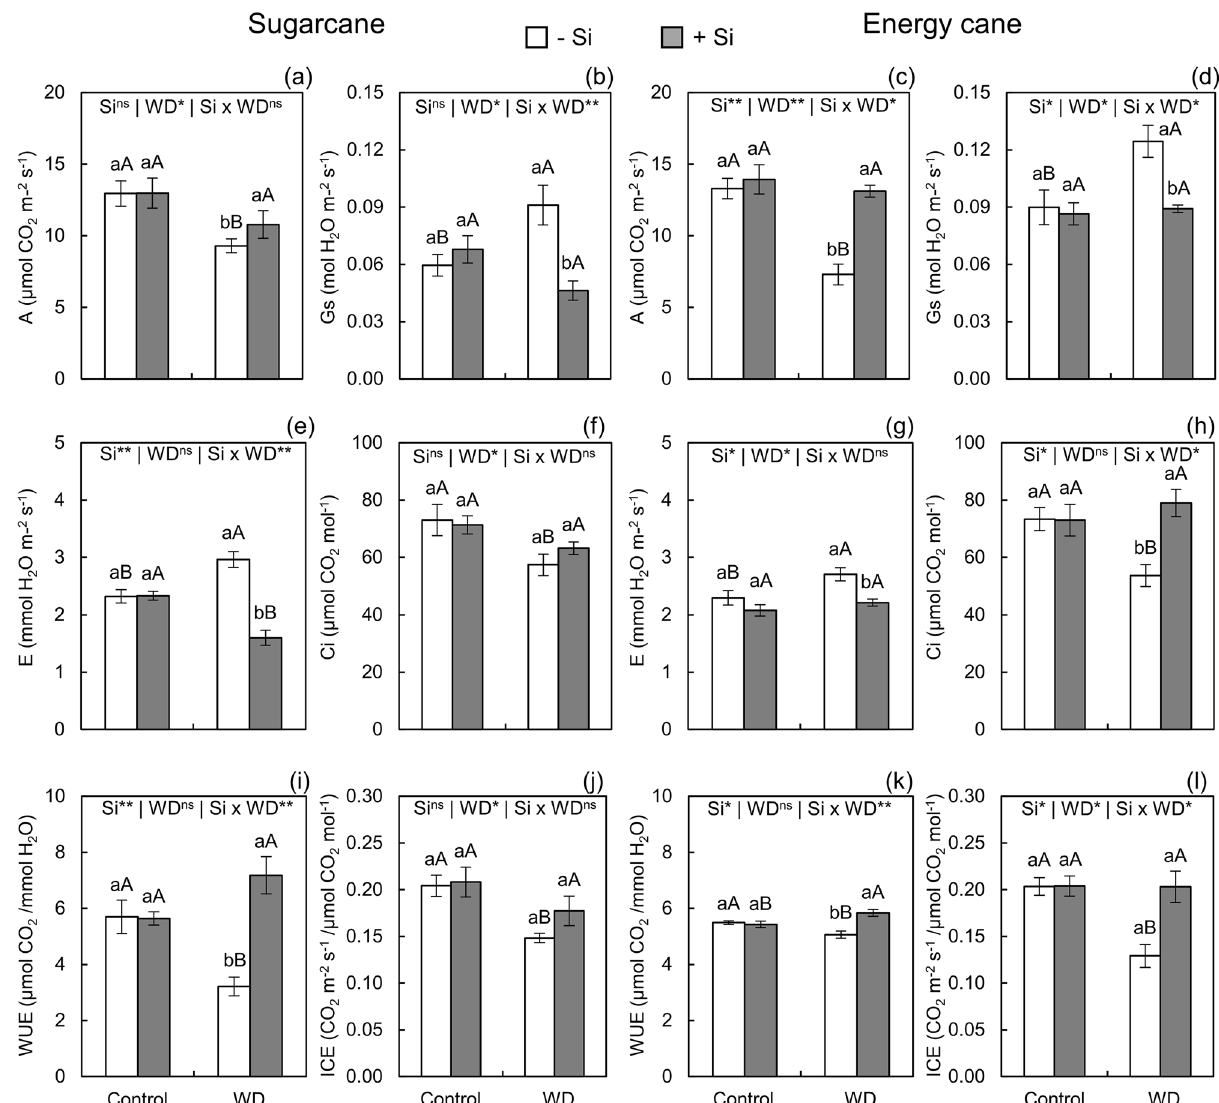
Figure 4. Photosynthesis rate (A), stomatal conductance (Gs), intracellular CO 2 concentration (Ci), leaf transpiration (E), water use efficiency (WUE), and instantaneous carboxylation efficiency (ICE) in sugarcane ( a , b , e , f , i , j ) and energy cane ( c , d , g , h , k , l ) in the absence of Si (-Si) and with Si applied via fertigation associated with foliar spraying (+ Si) under adequate water regime (control) and severe water deficit (WD) for a period of 7 to 160 days after transplanting. ** and * : significant at 1 and 5% probability, respectively; and ns : not significant by the F-test. Different lowercase letters indicate differences in relation to Si in the same water regime; different capital letters indicate differences in relation to the water regime in the same conditions of Si supply, both by the Tukey test. Bars represent the standard error of the mean; n = from Si supply in plants under water deficit, increasing by 123 and 15.2% in sugarcane and energy cane, respec- tively, in relation to plants under -Si (Fig. 4i,k). Plants of both species grown without Si supply had lower instantaneous carboxylation efficiency (ICE) in the water deficit regime than in the controlled water regime. However, nutrition with Si increased ICE in plants under water deficit, reaching values similar to those of plants of both species without water stress (Fig. 4j,l). Absence of Si supply increased H 2 O 2 content (Fig. 5a,b) and lipid peroxidation—expressed by MDA content (Fig. 5c,d)—in plants of both species grown under severe water deficit in relation to the controlled water regime. However, Si supply decreased H 2 O 2 content and lipid peroxidation in plants of both species under water deficit (Fig. 5a-d). The Si-induced decrease in H 2 O 2 and MDA made these concentrations similar to those of unstressed plants in sugarcane (Fig. 5a, c, d), but with lower H 2 O 2 in energy cane (Fig. 5b). Proline content increased with water deficit under both Si supply conditions in sugarcane and energy cane plants. However, Si supply accentuated the increase in proline content in plants under water deficit, reaching values higher than those of plants of both species grown under -Si (Fig. 5e, f).